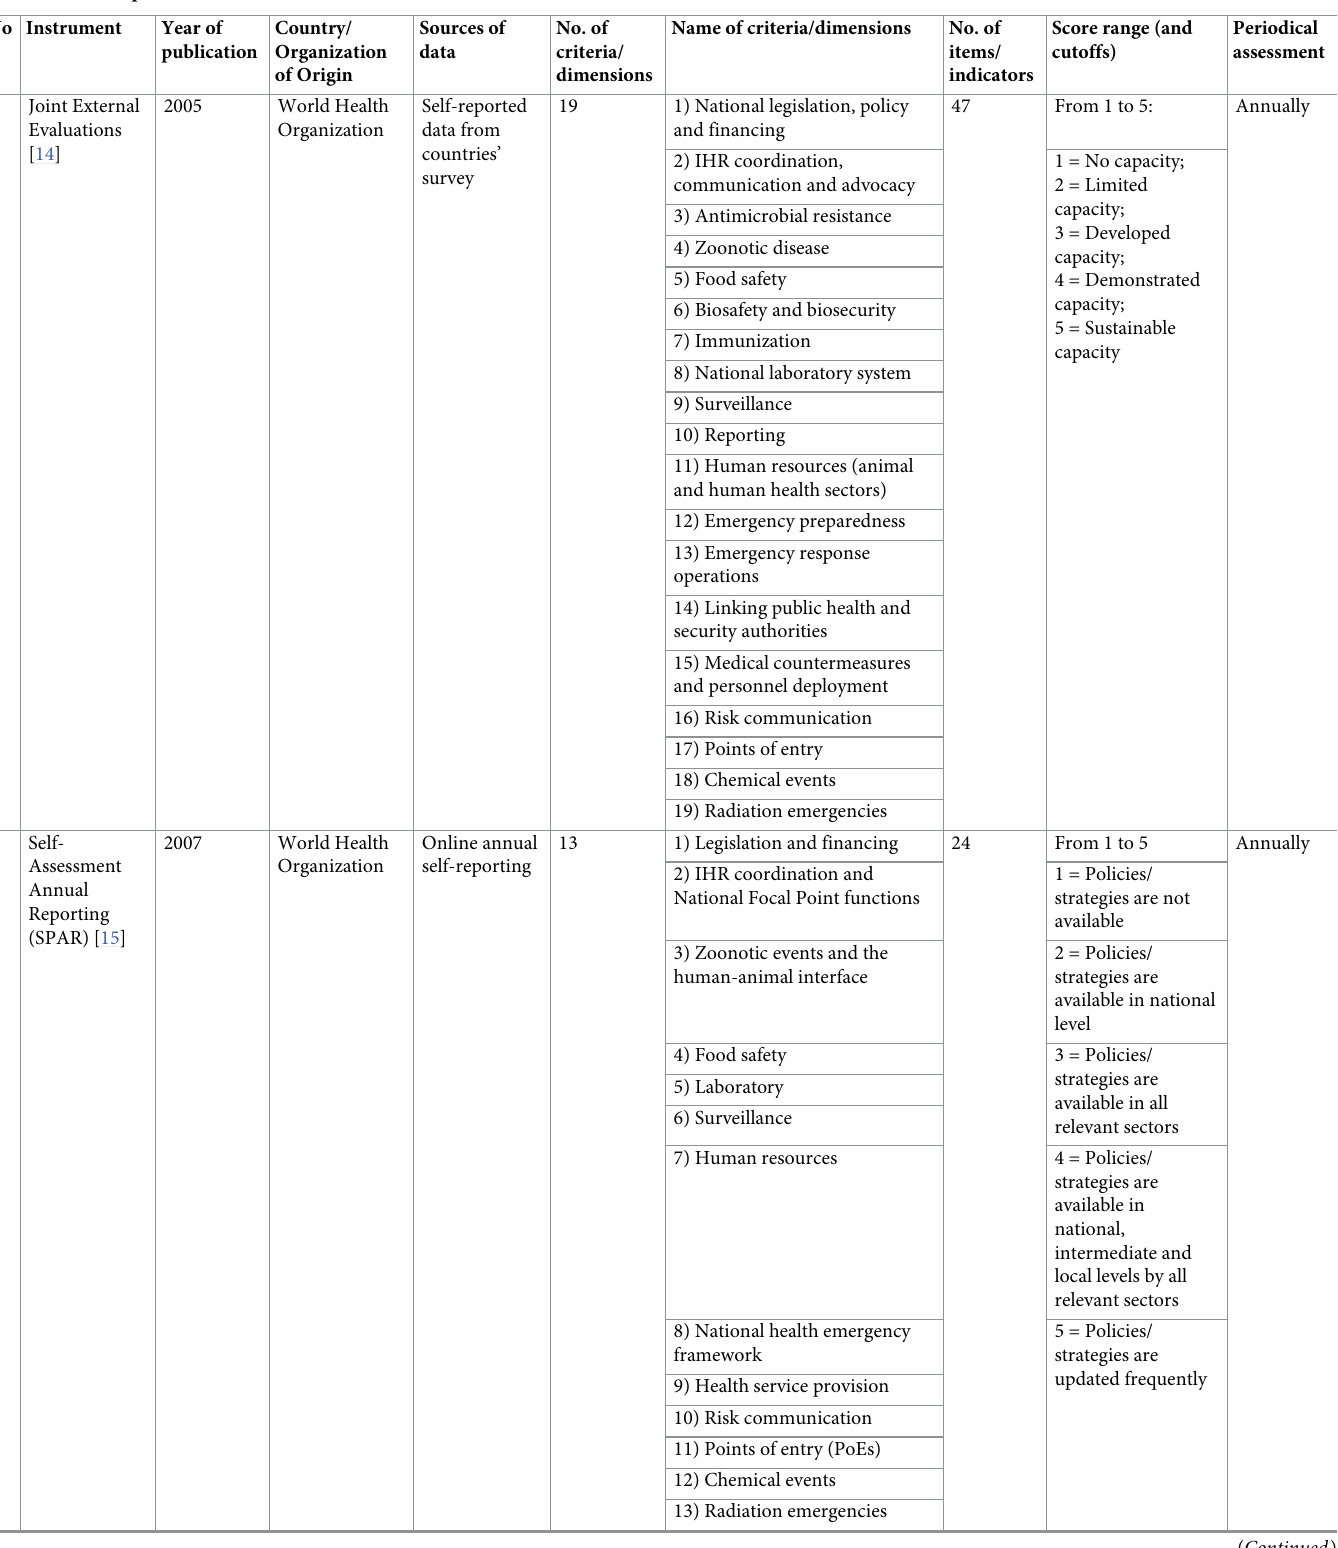
Table 3. General profiles of risk assessment